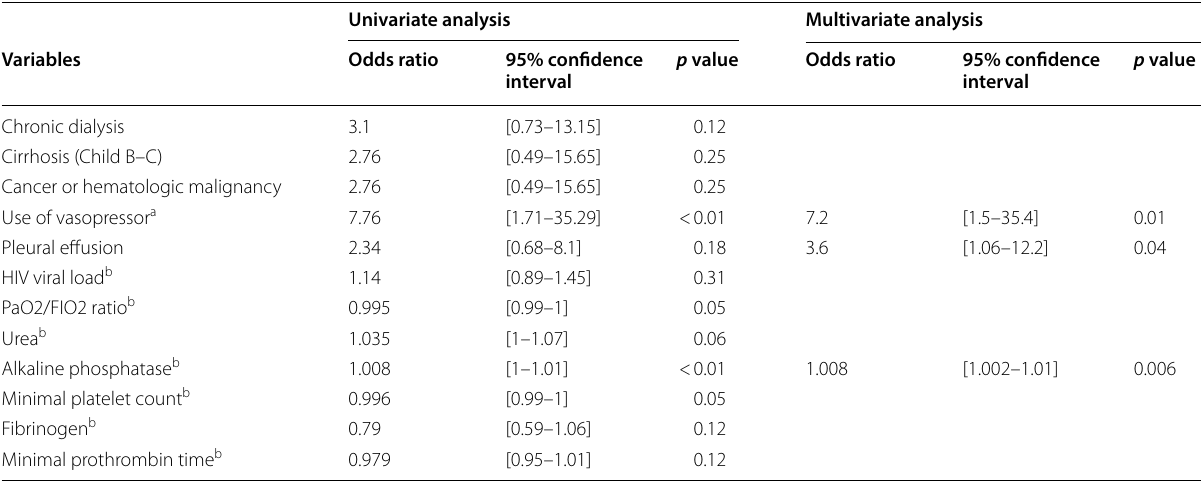
Table 5 Multivariate analysis of the risk factors for complicated course in 123 HIV-infected patients admitted to the ICU for acute respiratory